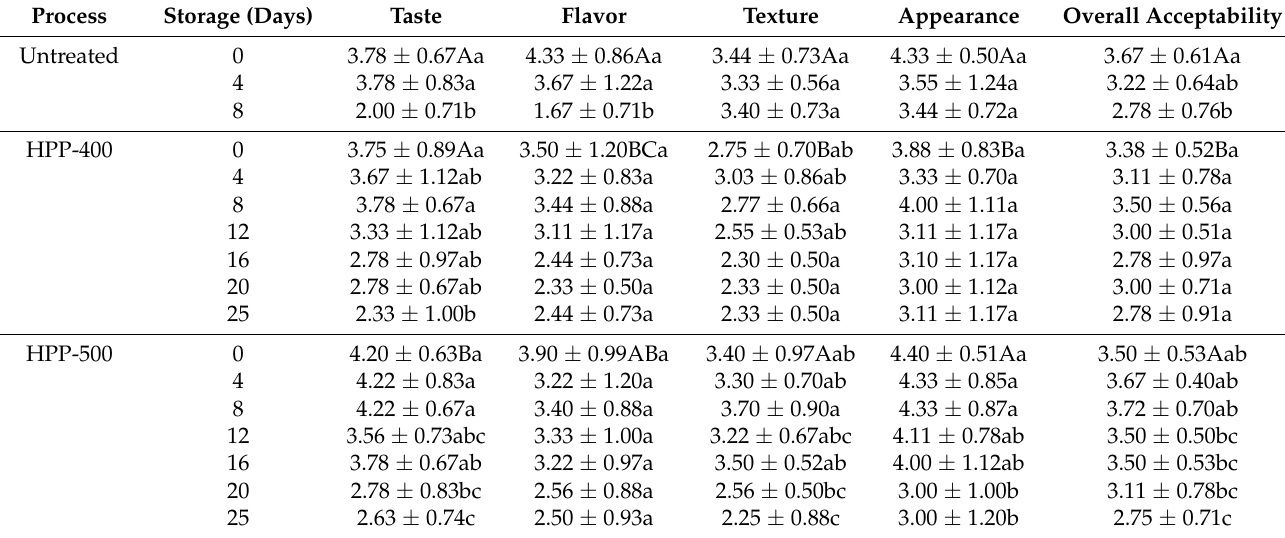
Table 5. Variations in the sensory scores of fresh-cut bell pepper during storage at 4 ◦